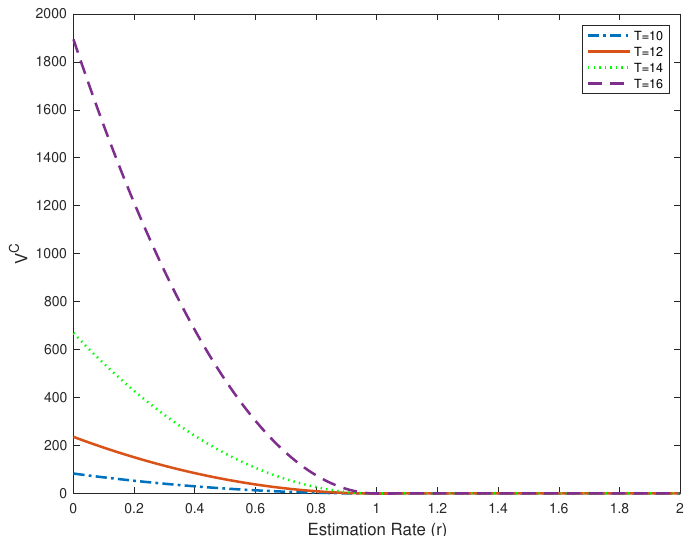
Figure 1. Normalized value of information for varied estimated initial pollution stock under different time intervals (X-axis denotes the estimation rate, Y-axis denotes the value of V C ).